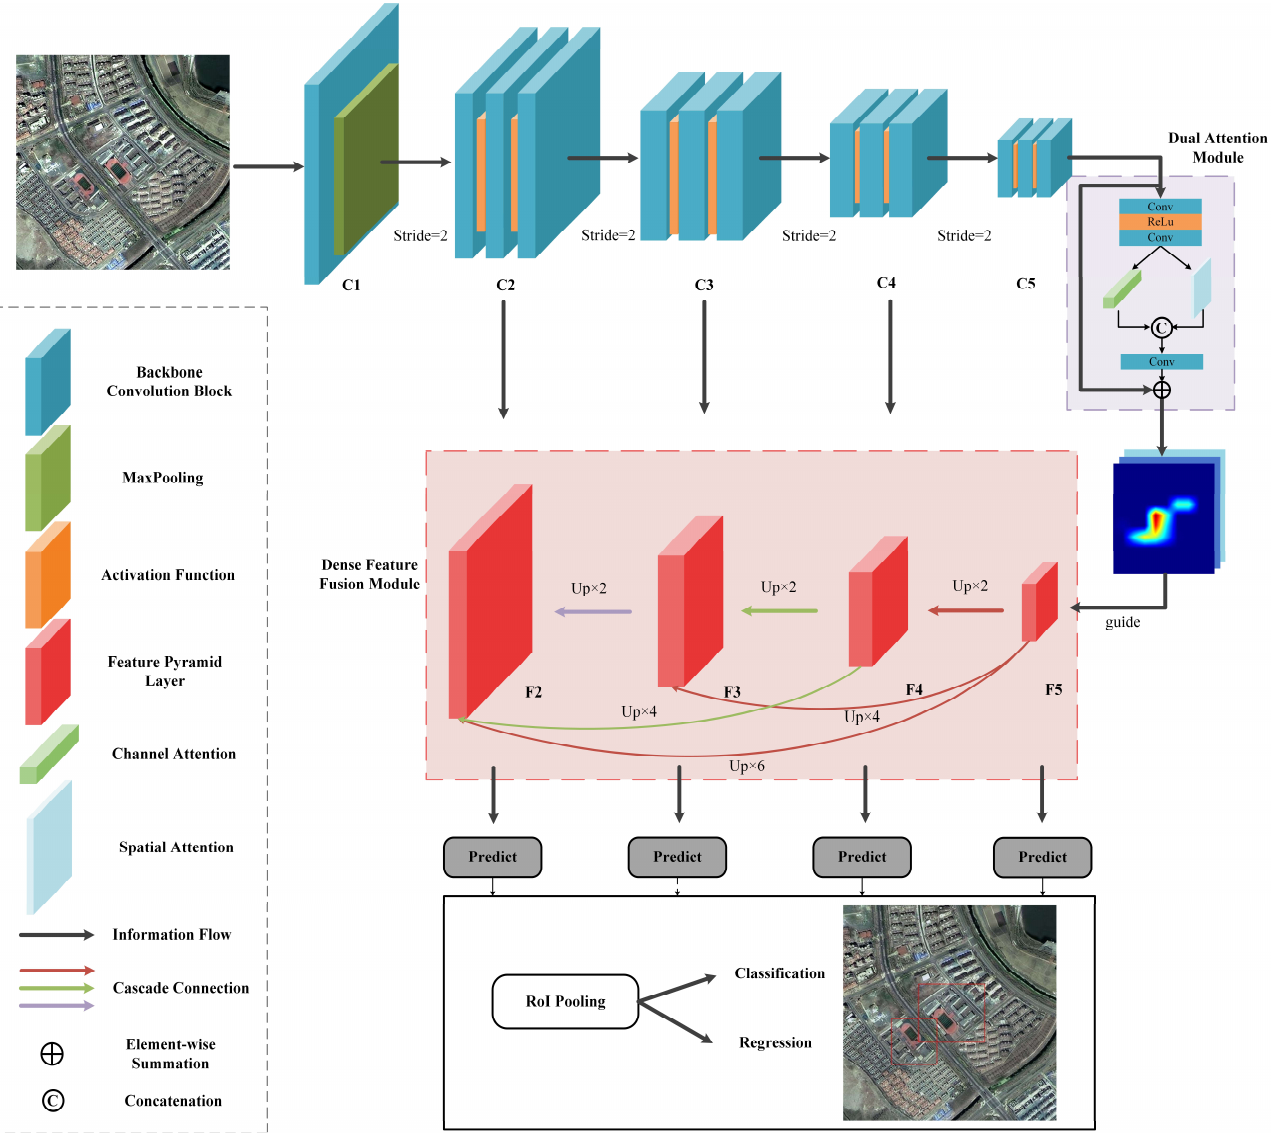
Figure 3. Overview of the proposed ADNet, which is built on the framework of Faster R-CNN. The features are guided by DAM and integrated by DFFM to gradually generate predictions.